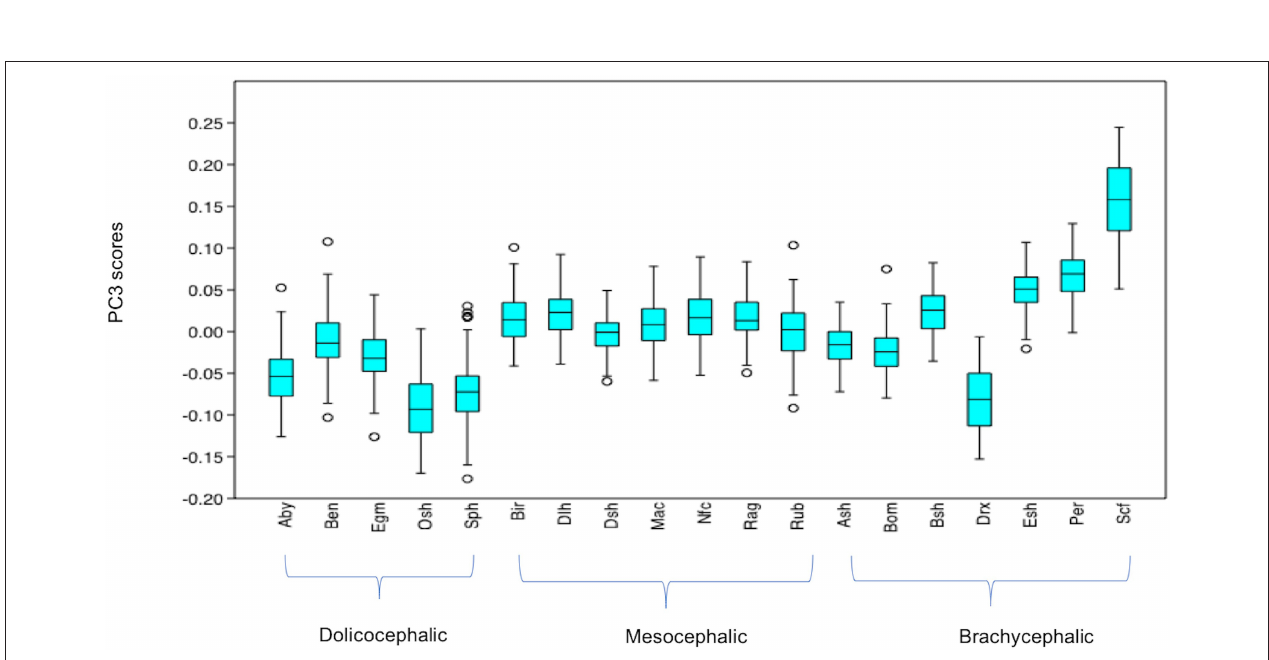
FIGURE 6 | Boxplot with minimum, first quartile, median, third quartile, maximum values and outliers (* denoting more extreme outliers) for PC1 scores for each breed, n = 1,888. Abbreviations for breeds within each cephalic type as follows. Dolichocephalic: Aby, Abyssinian; Ben, Bengal; Egm, Egyptian Mau; Osh, Oriental Shorthair; Sph, Sphynx. Mesocephalic: Bir, Birman; Dlh, Domestic Longhair; Dsh, Domestic shorthair; Mac, Main Coon; Nfc, Norwegian Forest cat; Ragdoll, Russian Blue. Brachycephalic: Ash, American Short hair; Bom, Bombay; Drx, Devon Rex; Esh, Exotic Short hair; Per, Persian; Scf, Scottish fold. For full results of Mann Whitney U -tests see Supplementary Data 5 . For shape changes associated with higher PC1 scores, see Figure 1 . *Indicates significant individual outliers from the population.